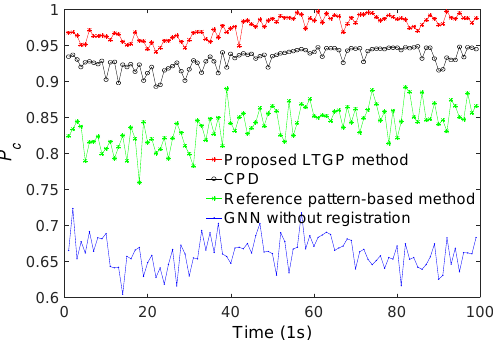
Figure 6. Correct association probabilities of GNN without registration, reference pattern-based algorithm, CPD algorithm and the proposed